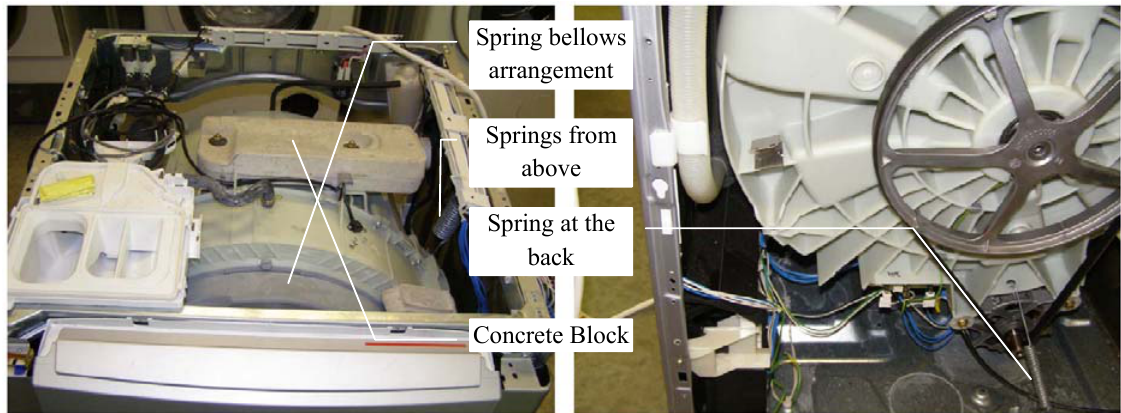
Figure 8. Washing machine drum’s